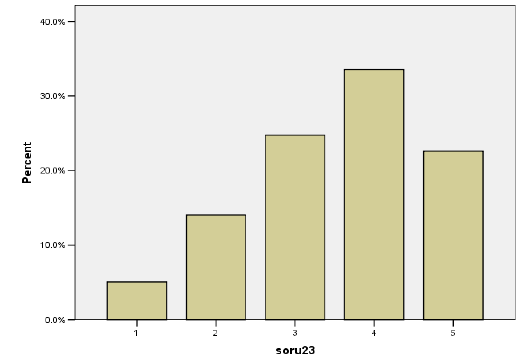
Figure 13. Should accounting education give more importance to analysis and interpretation compared to recording and entries? accounting and auditing standards?